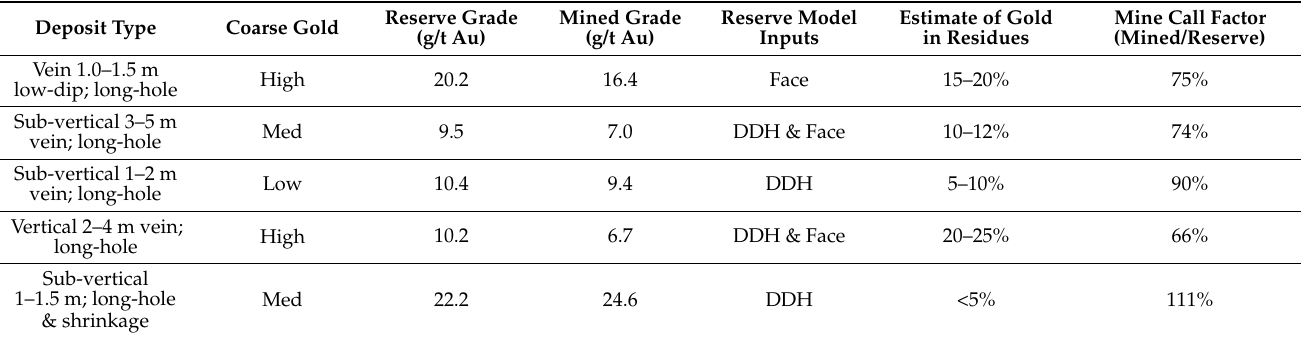
Table 1. Examples of the gold content of broken ore residues. A DDH: diamond drill core; Face: chip or channel samples. Reserve grade is based on block models using the reserve input data. Mined grade is back-calculated from gold yield and tailing samples. The estimate of gold in residues is based on a sampling of drive and/or stope